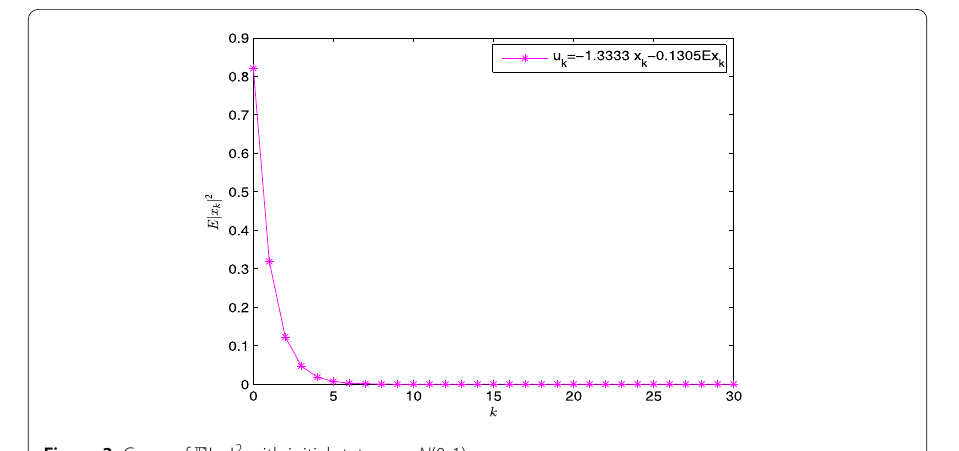
Figure 3 Curve of E | x k | 2 with initial state x 0 ∼ N (0,1)